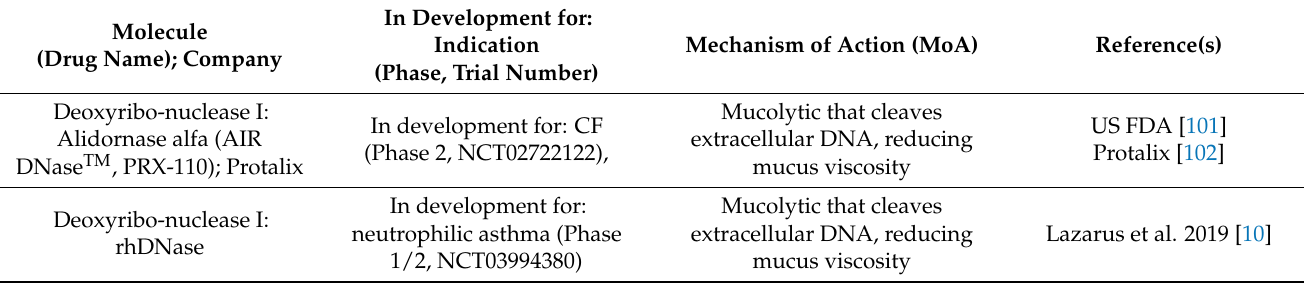
Table 3. Inhaled enzyme therapeutics for respiratory conditions currently in